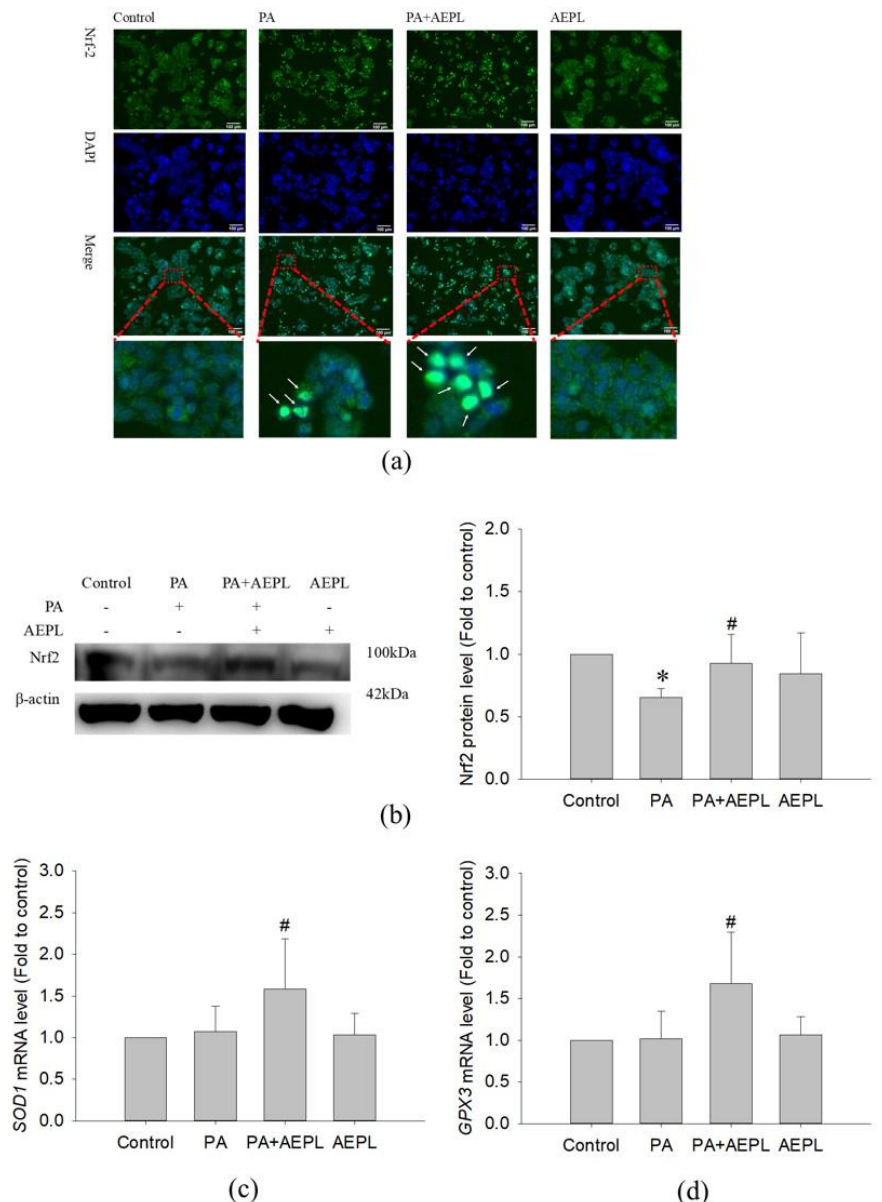
Figure 6. AEPL increased Nrf2 expressions and translocated to nucleus. ( a ) HepG2 cells were treated with AEPL in presence/absence of PA for 24h. Nrf2 localization was determined by using immunocytometry with Nrf2 antibody (green fluorescence). Blue fluorescence was DAPI for staining nucleus. Scale bar, 100μm. ( b ) Nrf2 protein levels in HepG2 cell lysates by Western blotting and normalizing to that of β-actin. ( c ) The mRNA levels of the SOD1 gene were normalized to that of the ACTB gene. ( d ) The mRNA levels of the GPX 3 gene were normalized to that of the ACTB gene. All data were presented as mean ± SD of three independent experiments. * p < 0.05 vs. control cells; # p < 0.05 vs. PA-treated cells.